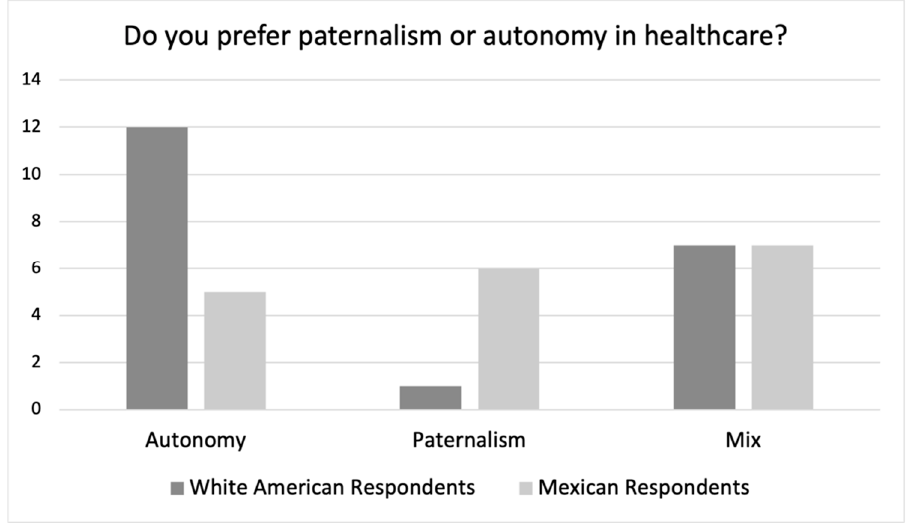
Figure 1. White American and Mexican Respondents’ Preferences.